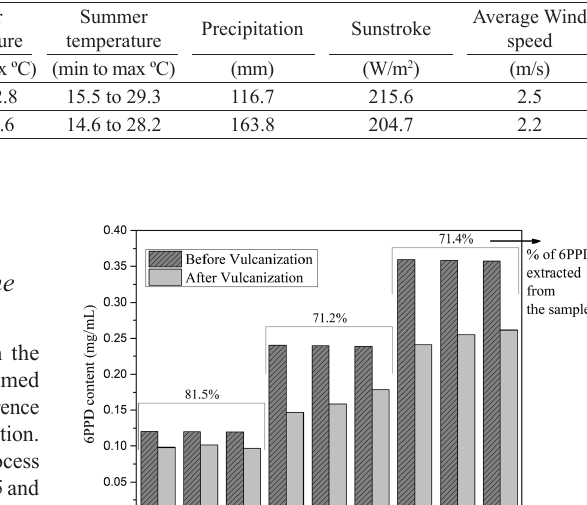
Table 2. Weather parameters throughout the environmental test (November of 2011 until February 2013).